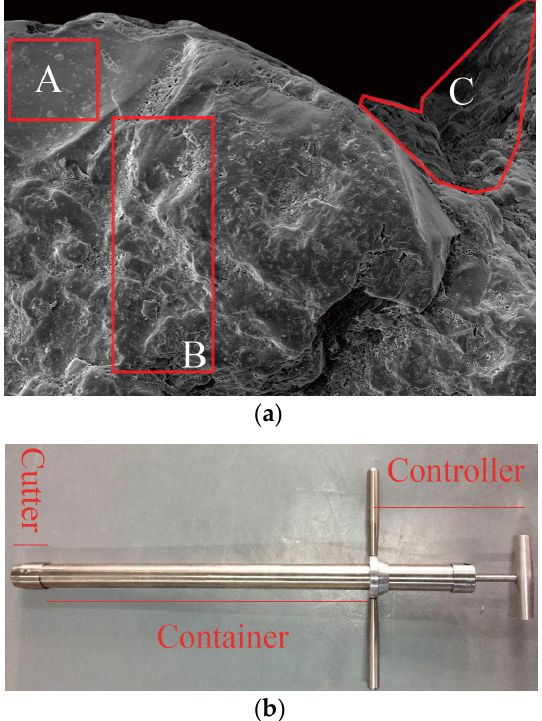
Figure 3. SS and driller. ( a ) SS image (Zone A was the SiO 2 matrix; Zone B was the Cl − complex; Zone C was the saline minerals of K + , Al 3+ , and Na + ). ( b ) Driller (Cutter helped break the consolidated cover on the shelf; container carried the SS particles; controller was operated by human or machine to press the driller into the deep SS layer).